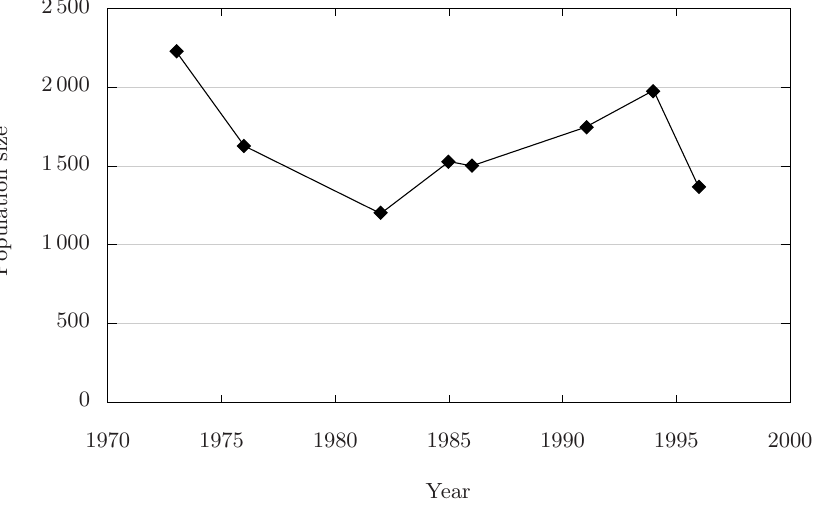
Figure 1: Survey estimates of the white rhino population size from